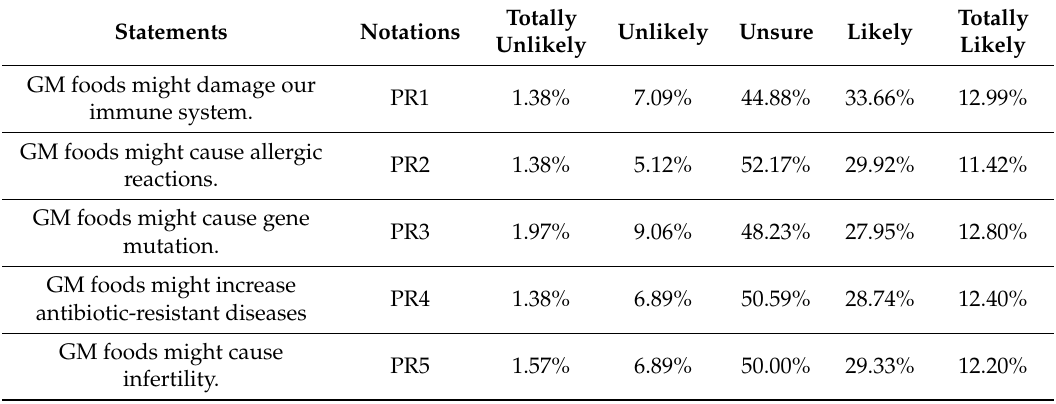
Table 2. Frequency distribution of responses to perceived risks statements.